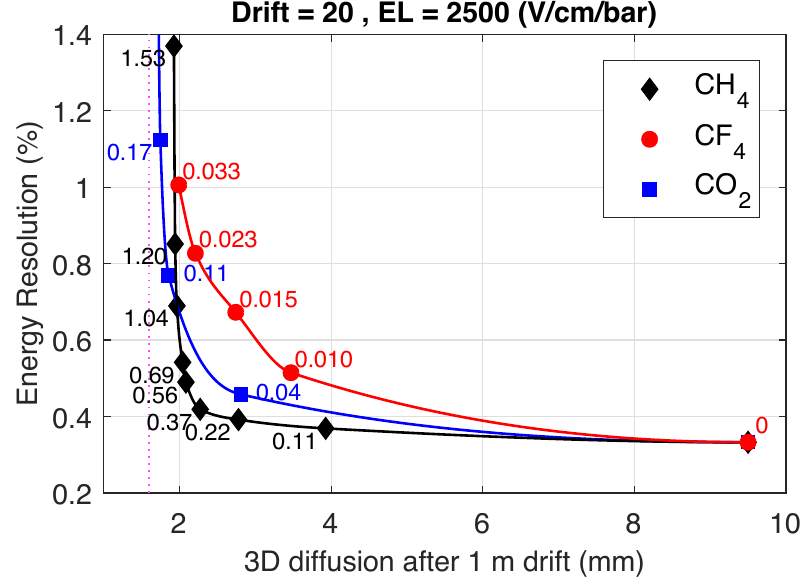
Figure 8 . Energy resolution extrapolated to the energy of a (cid:12)(cid:12) 0 (cid:23) decay event (2.5 MeV) and to the NEXT-100 TPC operating conditions ( E=p = 20 V/cm/bar in the drift region and E=p = 2 : 5 kV/cm/bar in the EL region), as a function of the simulated 3D di(cid:11)usion after 1 meter drift, for di(cid:11)erent concentrations (indicated in %) of the molecular additives investigated in this work (CO 2 , CH 4 and CF 4 ). The vertical line indicates the thermal di(cid:11)usion for the described